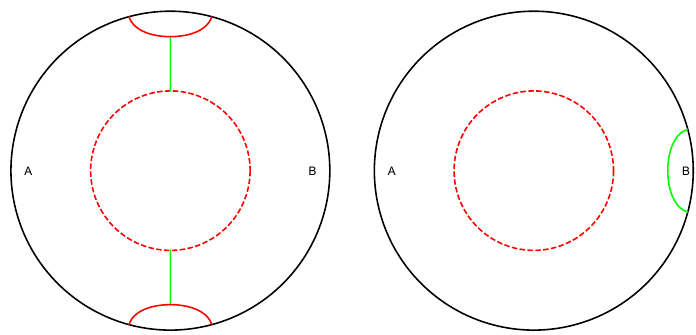
Figure 5. Left: the E ph geodesic is in green, and the RT surface (including the horizon) is in red. Right: when the Araki-Lieb inequality is saturated, the E ph coincides with S ( B ). Case